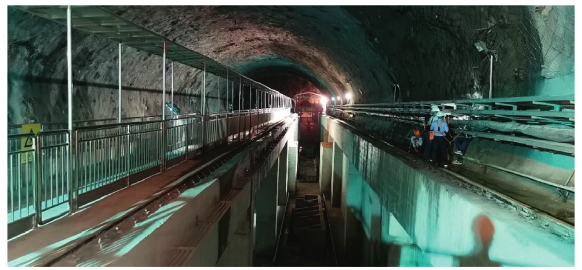
Figure 1: The field investigation in the tailrace surge